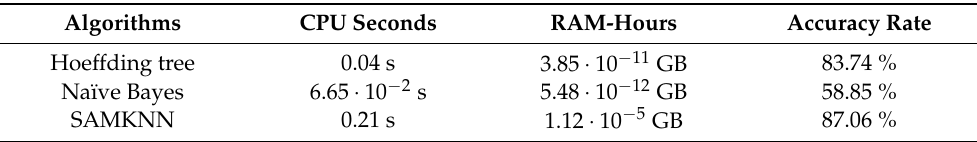
Table 1. Average results of the algorithms’ evaluation.